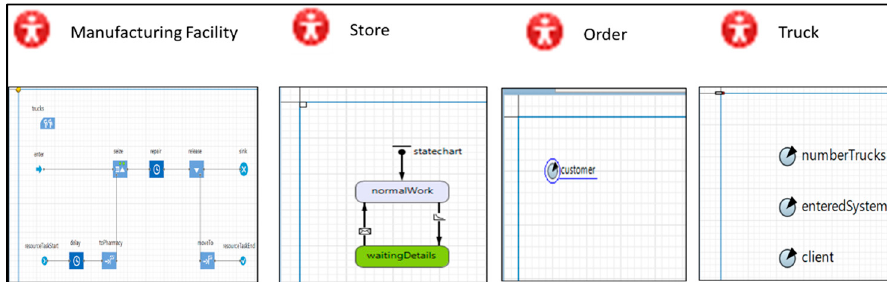
Figure 6. The structure of each agent in the agent ‐ based simulation model (ABSM).